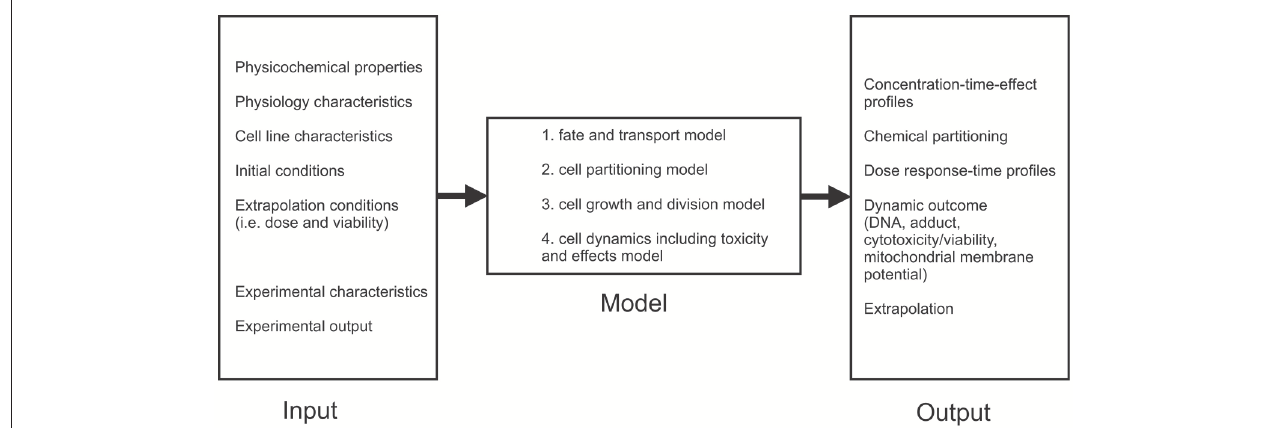
FIGURE 3 | Schematic representation of VCBA model.